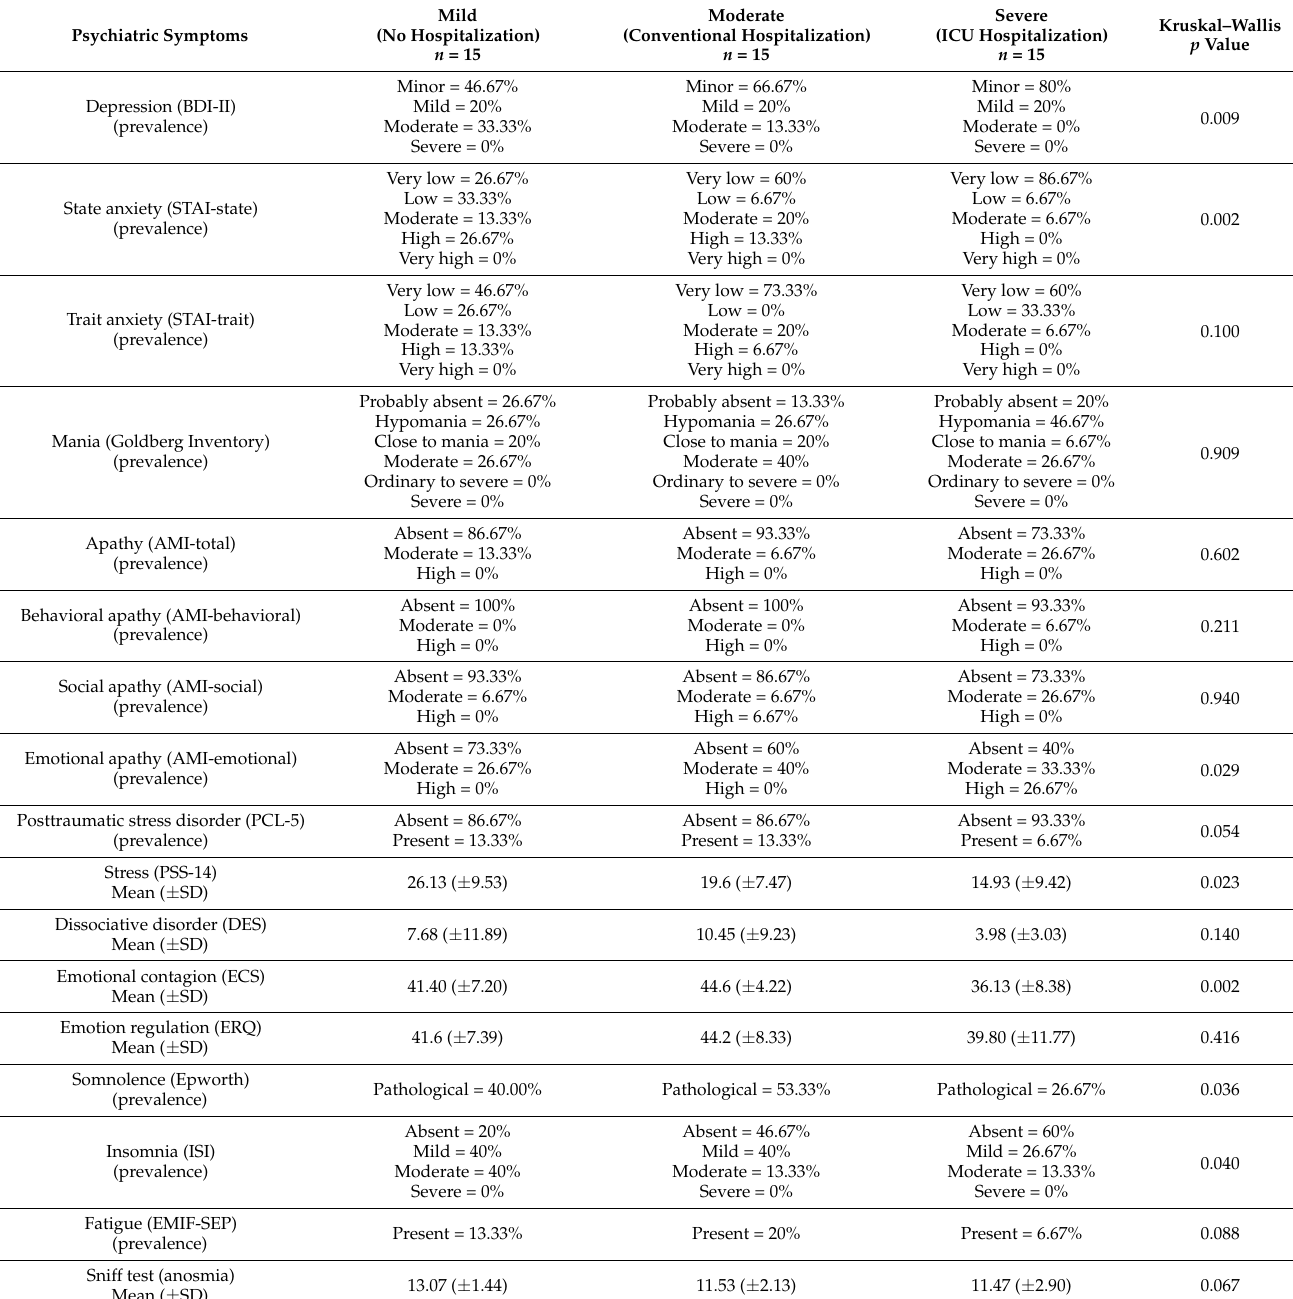
Table 3. Psychiatric symptoms and olfaction in patients with mild, moderate, or severe COVID-19 6–9 months